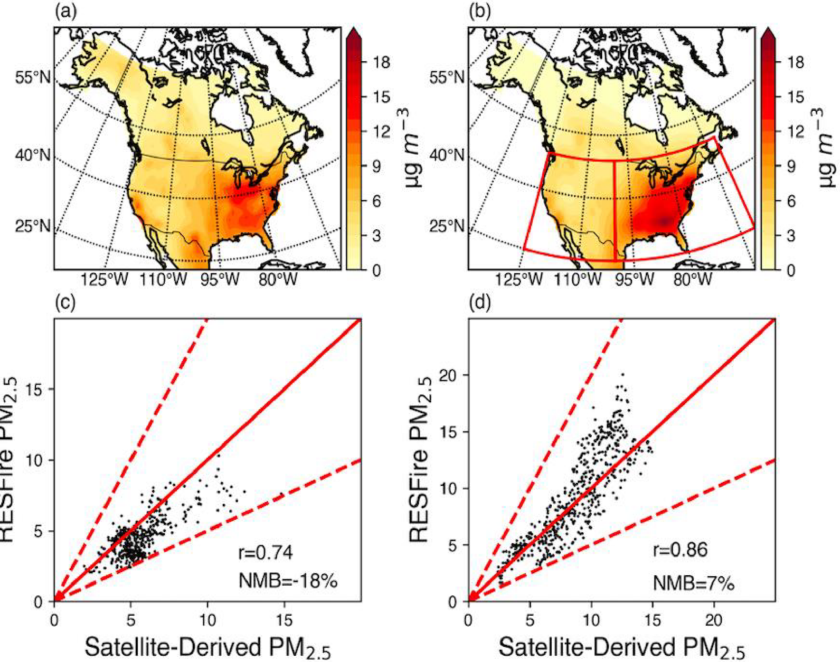
Figure 1. Comparison of the 10-year-averaged (2001–2010) annual-mean surface PM 2 . 5 concentration between observations and RES- Fire simulations. (a) Satellite-derived surface PM 2 . 5 concentrations (with dust and sea salt removed) estimated by van Donkelaar et al. (2018) (available at https://sedac.ciesin.columbia.edu/data/set/sdei-global-annual-gwr-pm2-5-modis-misr-seawifs-aod, last access: 5 November 2021). (b) The 2000 ALL simulated surface PM 2 . 5 concentrations (with dust and sea salt removed) averaged over 2001–2010; the red boxes denote the two subregions (EUS and WUS) shown in Fig. 2 in the main text. (c) Comparison of simulated and satellite-based gridded surface PM 2 . 5 concentrations in the WUS subregion; the number of samples is equal to the number of land grids ( ∼ 450). (d) Same as (c) but in the EUS subregion. The number of samples is equal to the number of land grids ( ∼ 375). The solid and dashed red lines denote the 1 : 1 ratio line and ± 100% biases, respectively. The correlation coefficients and NMB values are shown at the lower-right corner of each